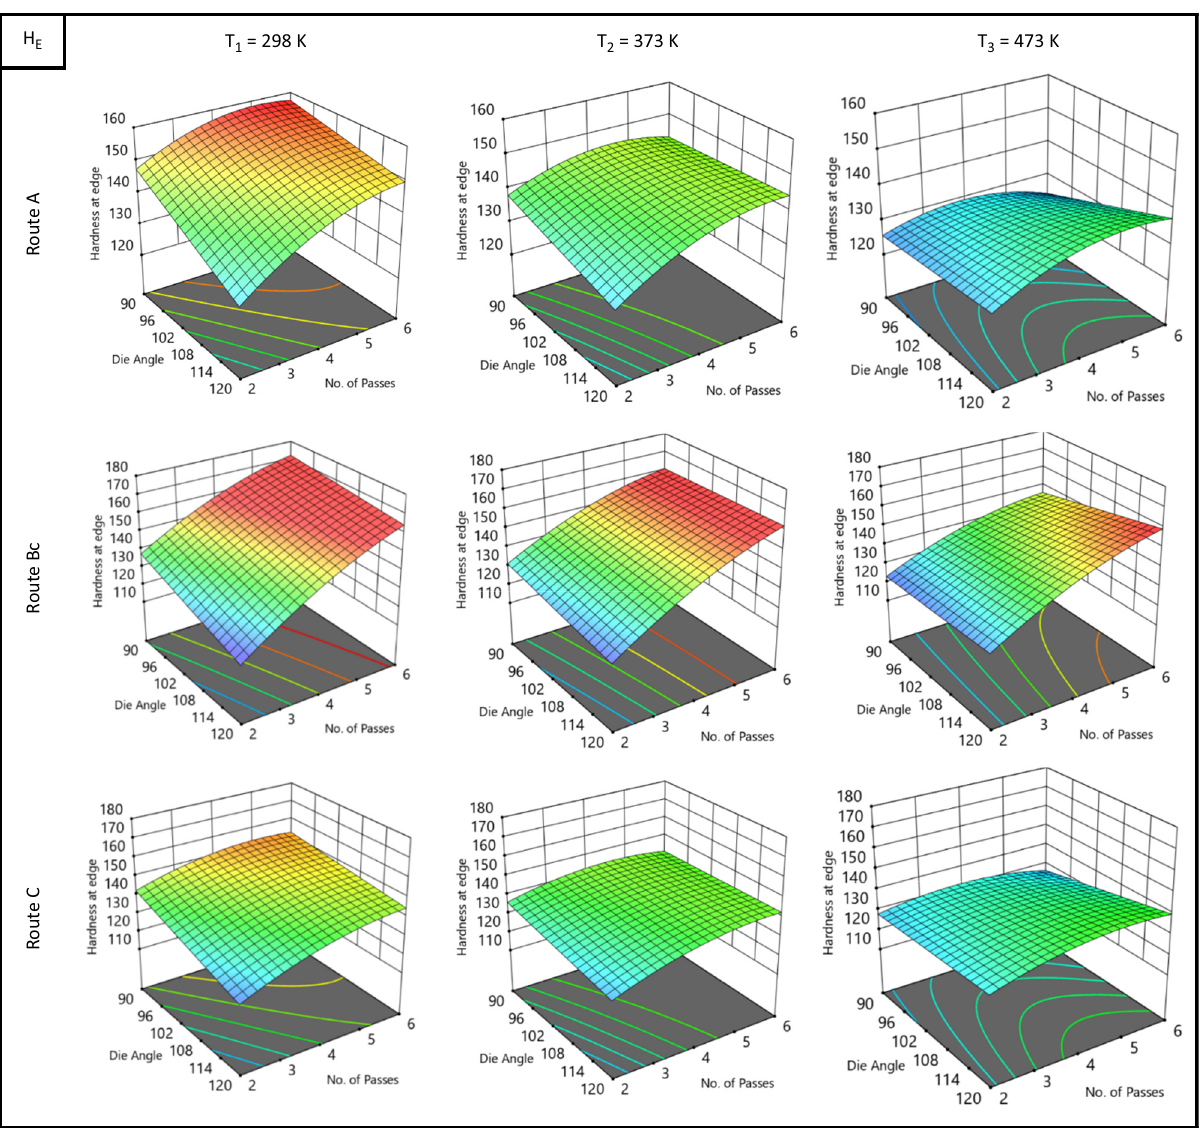
Figure 13: Response surface plot of H E as a function of die angle, number of passes, route type, and processing